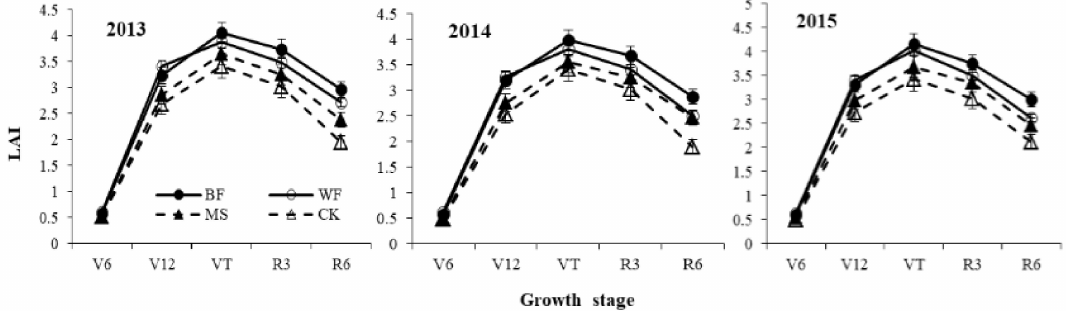
Figure 3. LAI of maize at di ff erent growth stages under di ff erent treatments in 2013, 2014, and 2015. LAD was also a ff ected by the three mulching materials (Table 5). LAD at the pre-tasseling stage was significantly higher under both film mulches (BF and WF) than under straw (MS) and the control (CK); the LAD under MS was significantly higher than CK, but there was no significant di ff erence between the LAD of the WF and BF treatments pre-tasseling. However, LAD post-tasseling was significantly higher under BF, followed by WF, MS, and CK. Total LAD under BF was highest, and that of CK was lowest. On average, the LADs under BF, WF, and MS were 41.8%, 26.7%, and 10.9% higher